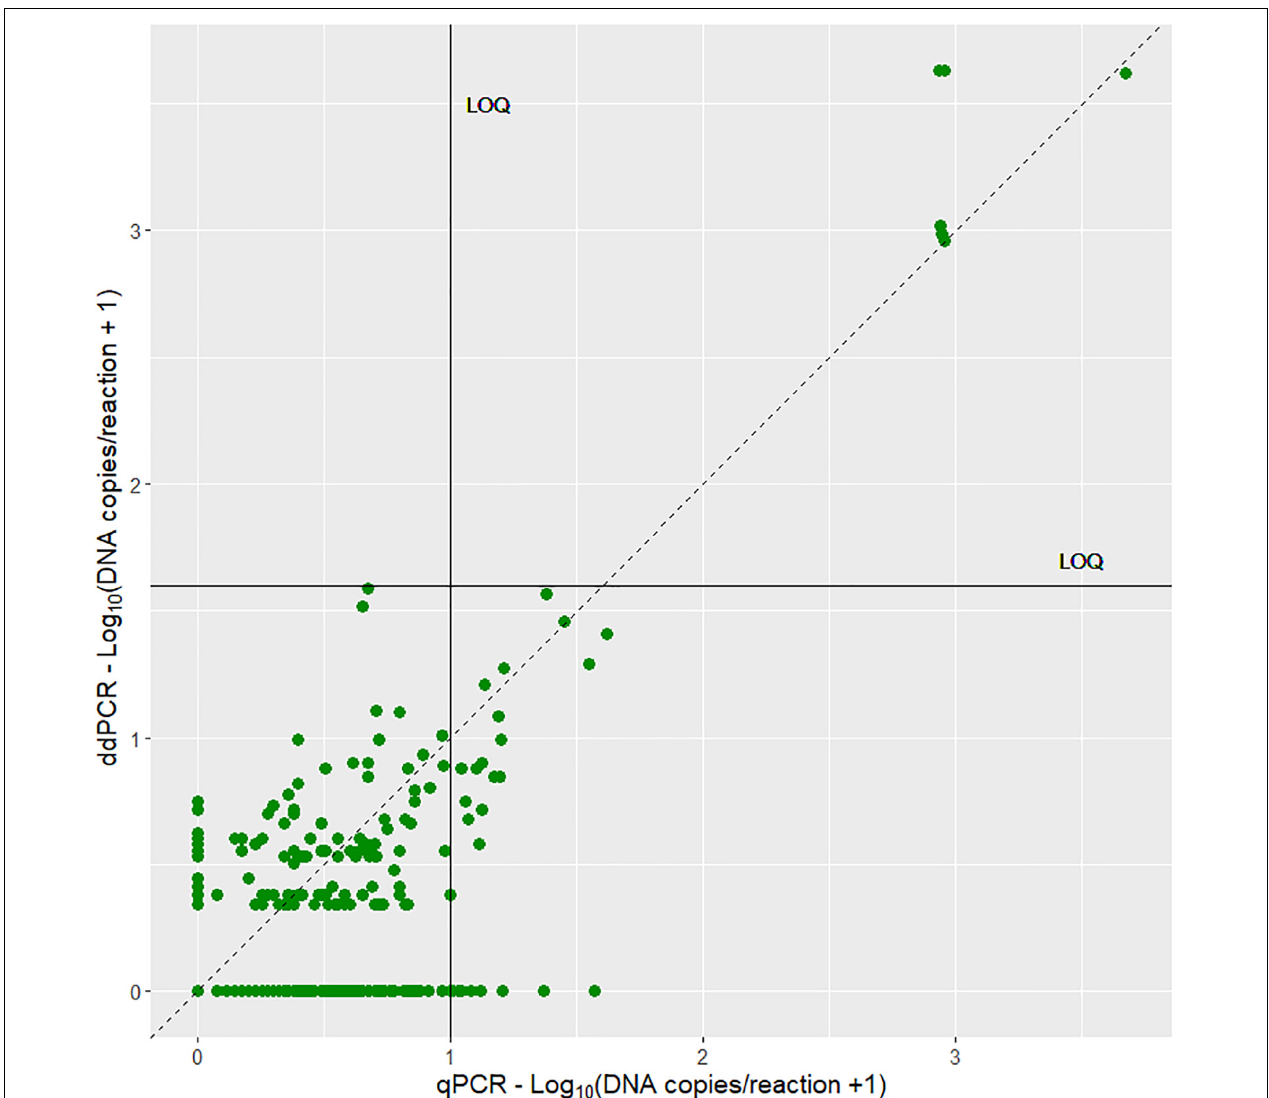
FIGURE 3 | A scatterplot of the estimated DNA copies per reaction of qPCR and ddPCR analysis of eDNA. The stippled line indicates a 1:1 ratio, while the horizontal line and vertical line indicates the LOQ for ddPCR and qPCR,